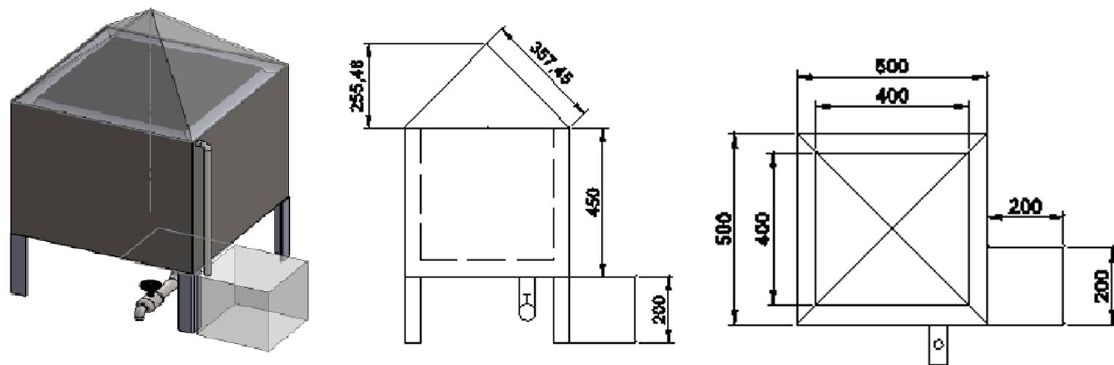
Figure 1. Schematic diagram for the solar still.